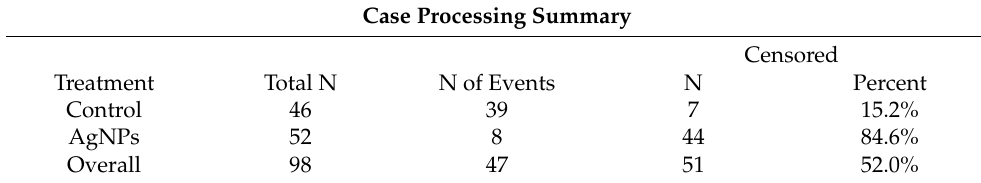
Table 7. Kaplan–Meier Method (Groups 1a and 1b).